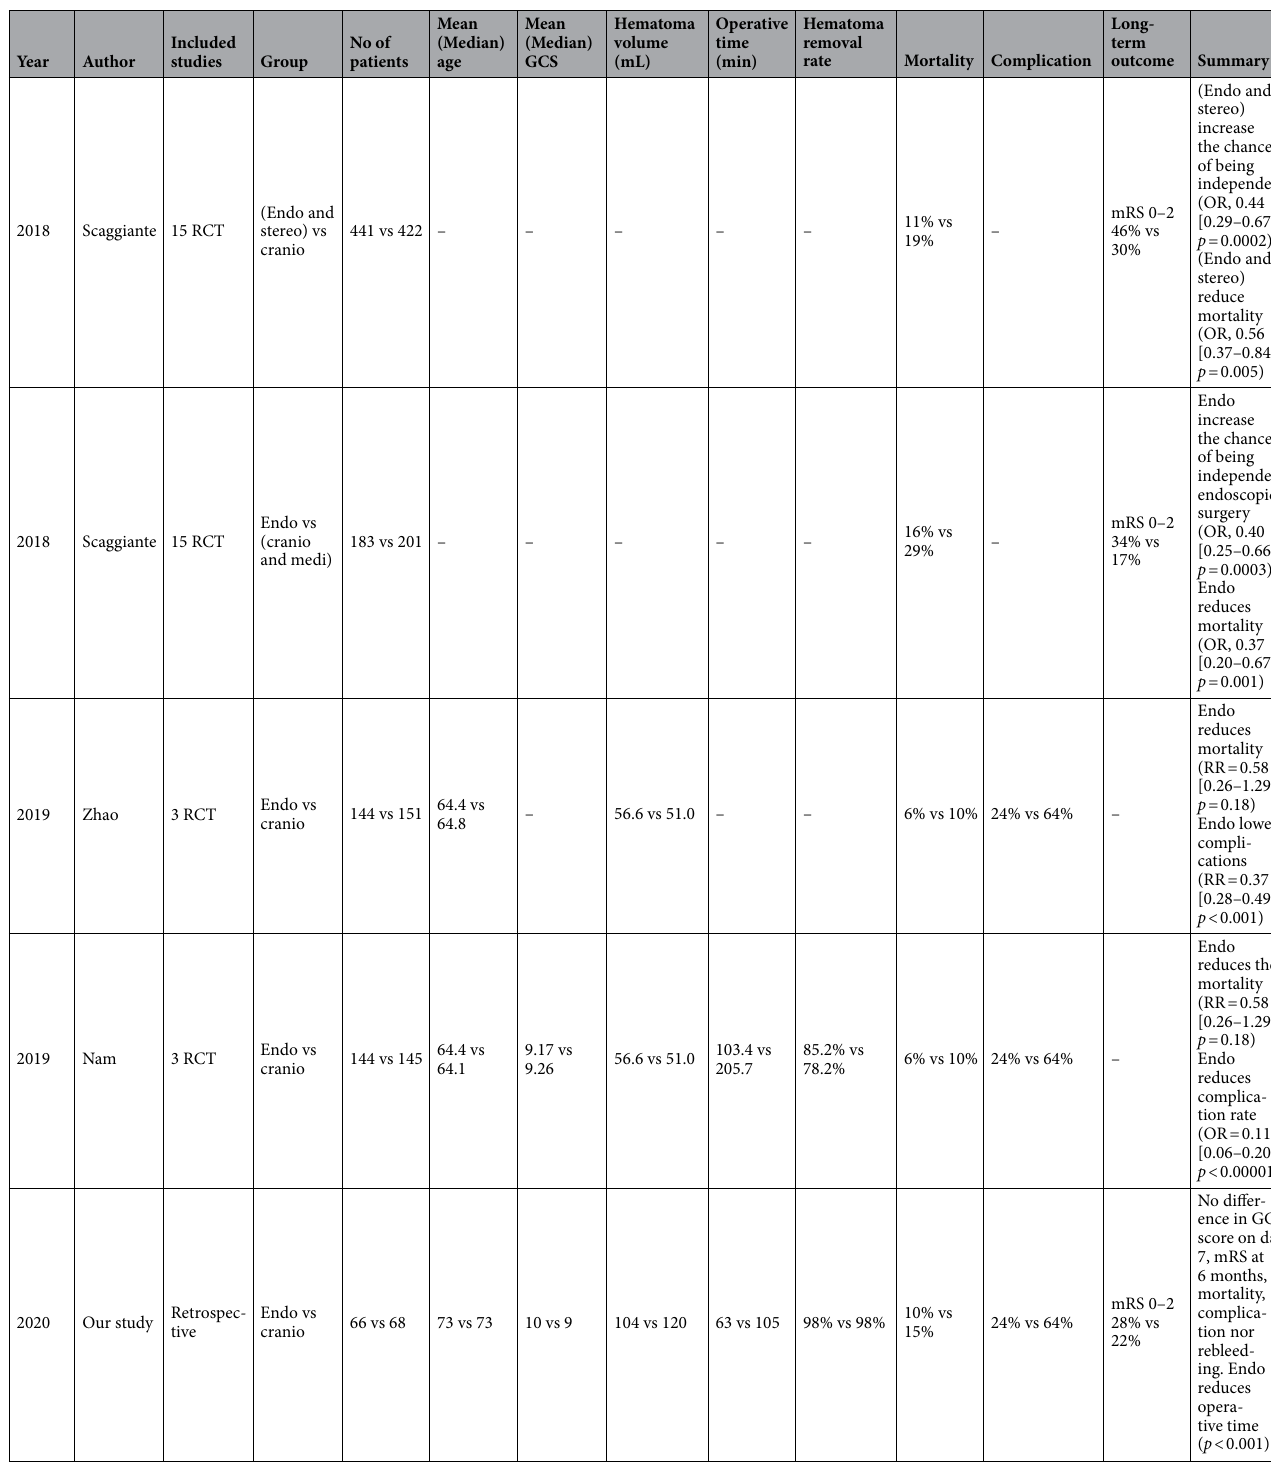
Table 1. Comparison between our results and previous meta-analyses for supratentorial ICH 26–28 . Results in previous reports by the mean; our results are shown by the median. GCS, Glasgow Coma Scale; cranio, hematoma removal with craniotomy; endo, endoscopic hematoma removal; medi, medication; mRS, modified Rankin Scale; RCT, randomized controlled trial; stereo, stereotactic hematoma evacuation; –, not described in